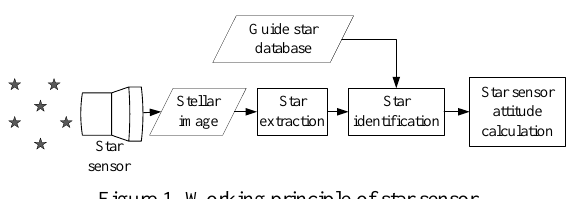
Figure 1. Working principle of star sensor